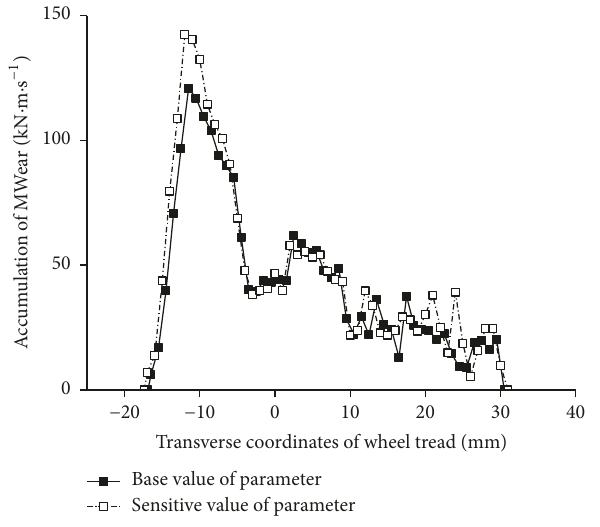
Figure 12: Wheel tread (unit: mm).